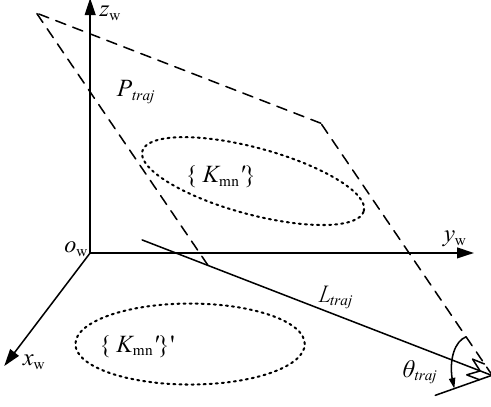
Figure 8. Transformation of spatial circle.